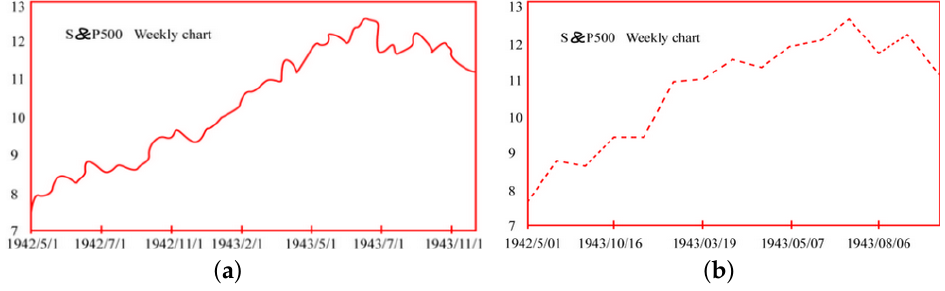
Figure 7. Example of data preprocessing. ( a ) An example of the weekly K-chart of the S&P 500 Index. ( b ) Unified step size result of PLR_VIP